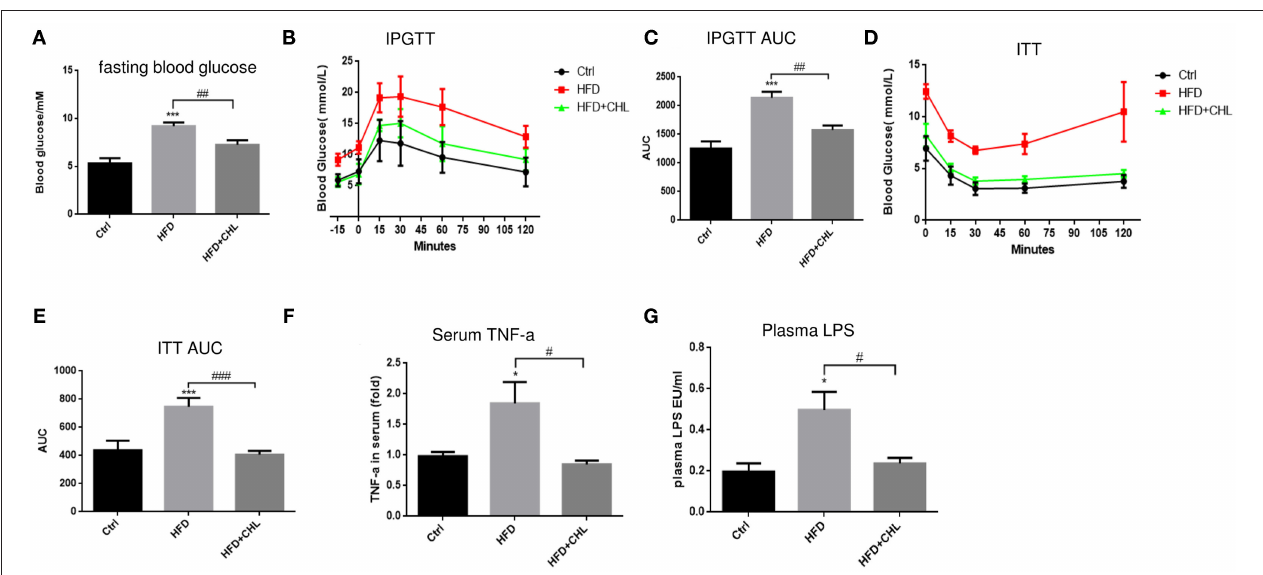
Frontiers in Physiology |